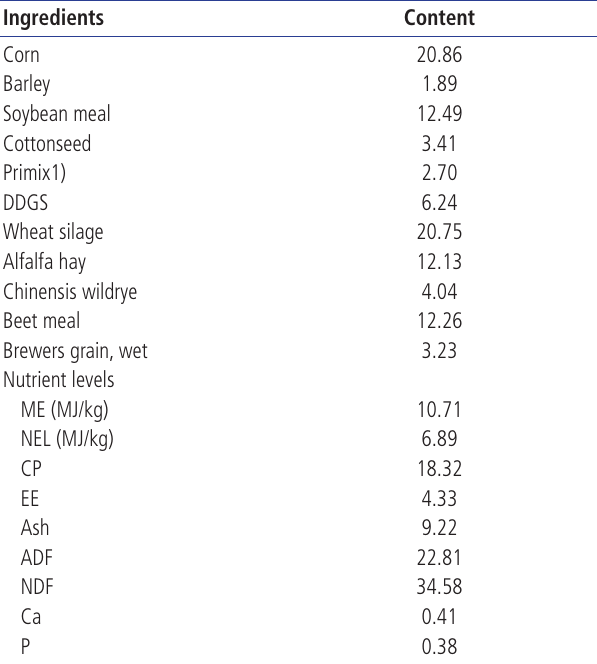
Table 3. Composition and nutrient levels of basal diet in dairy cows after parturition (DM basis) %